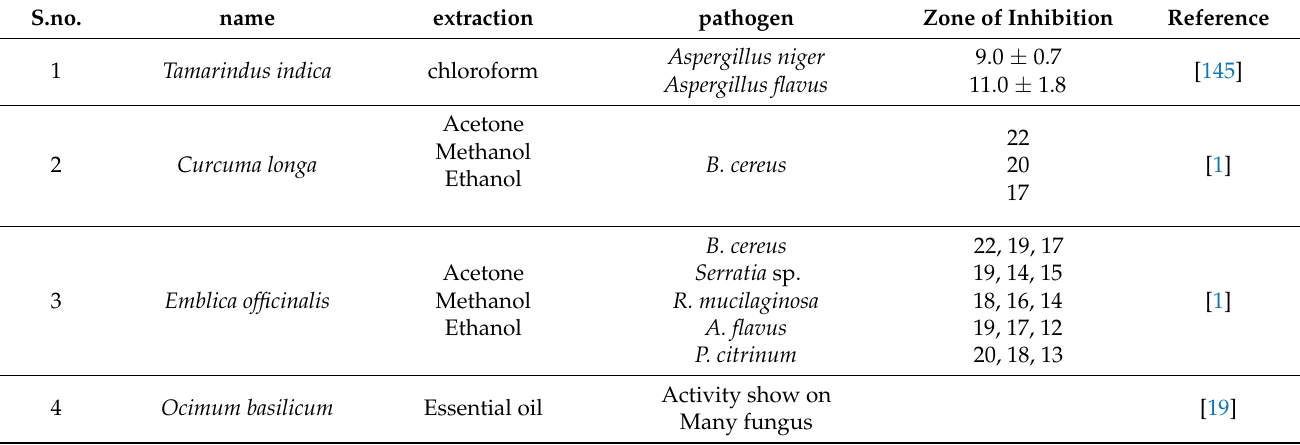
Figure 10. Zone of inhibition of microbial strain using different extraction of spices. Table 2. Antimicrobial activity of different extraction of spices; M (methanol); E (ethanol); A (acetone); Aq (aqueous); W (water).